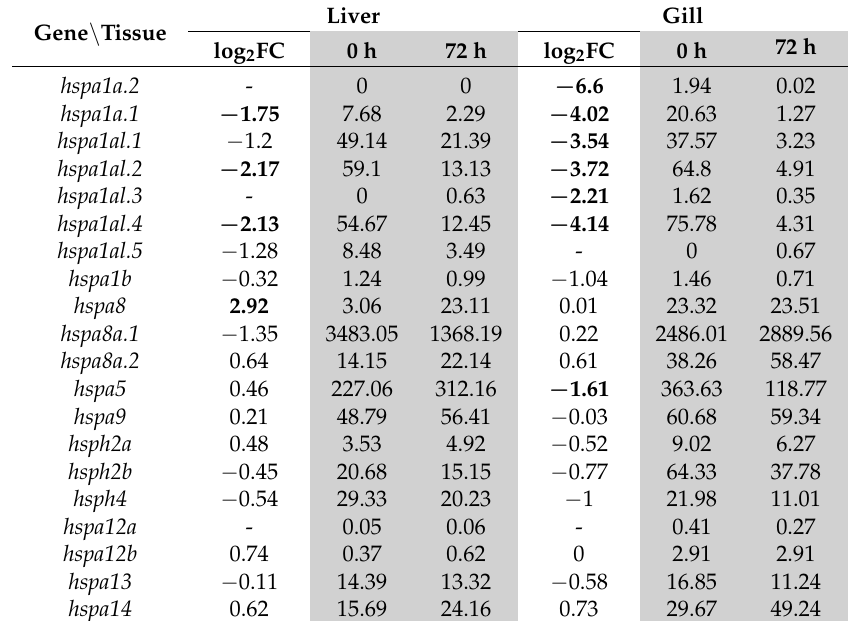
Table 3. Log 2 based fold change (log 2 FC) and the FPKM of B. pectinirostris Hsp70 gene expression in liver and gill at 0 h and after 72 h of HEA stress. The significant genes ( p value < 0.05, total reads number > 10, log 2 FC > 1.5) are in bold. The FPKM for expression estimations of different tissues are in shading.